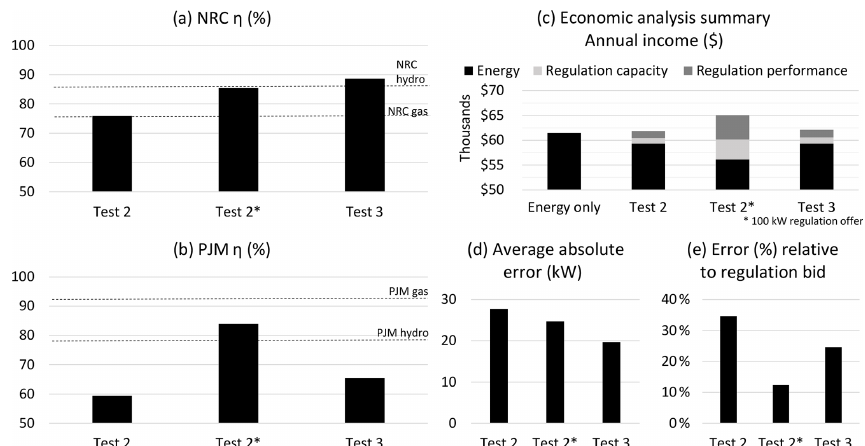
Figure 7. (a, b) Performance score summary. Dashed lines show performance figures for other generation technologies; (c) annual economic summary with various performance scores; (d) error trends in each test and (e) error relative to regulation bid magnitude. Table 2. Annual financial summary with 2017 PJM market data. (Also see Fig. 7.) Test η PJM Energy Regulation Regulation Total annual (%) income capacity performance